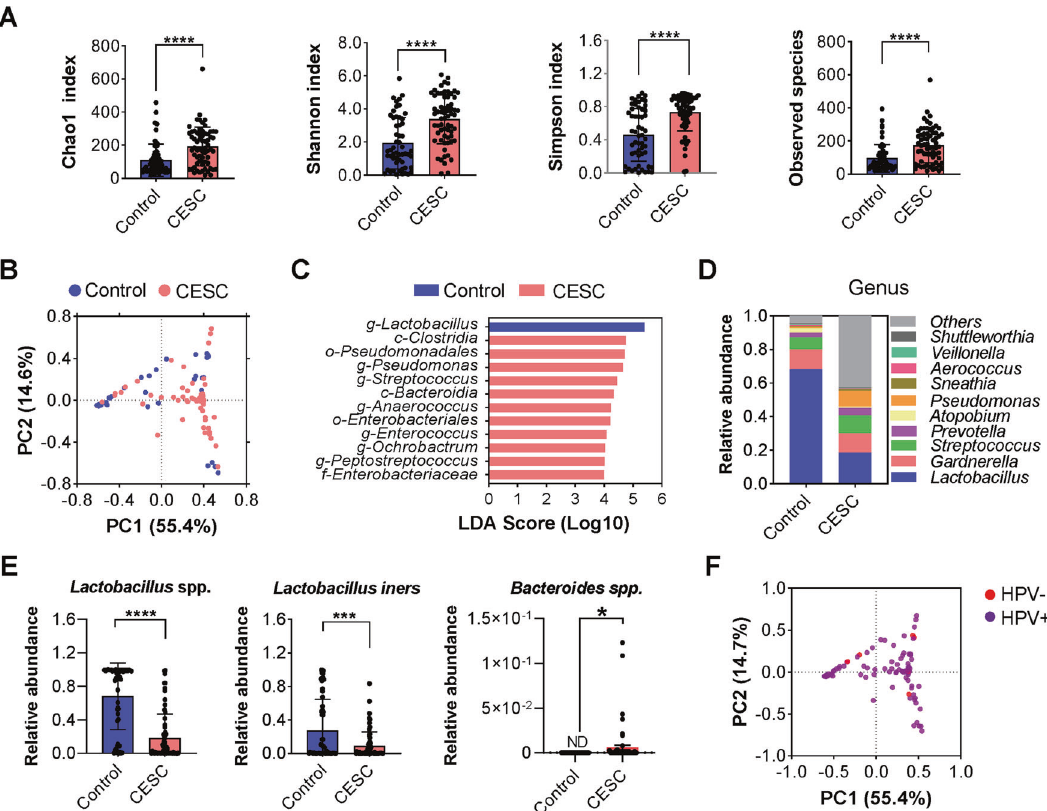
Fig. 3 Comparison of the vaginal microbiota structures of healthy volunteers and cervical cancer patients. A The alpha diversity of the two groups (indicated by the Chao 1, Shannon, Simpson indices). B The beta diversity of the two groups (expressed based on PCA). C The composition of dominant microbiota in the two groups (expressed based on LEfSe analysis). D The relative abundance of the top ten microorganisms at the gene level in the two groups. E Comparison of the relative abundance of Lactobacillus spp . and L. iners in the two groups. F Beta diversity of the HPV- and HPV + groups (expressed based on PCA). *** p < 0.001, **** p <